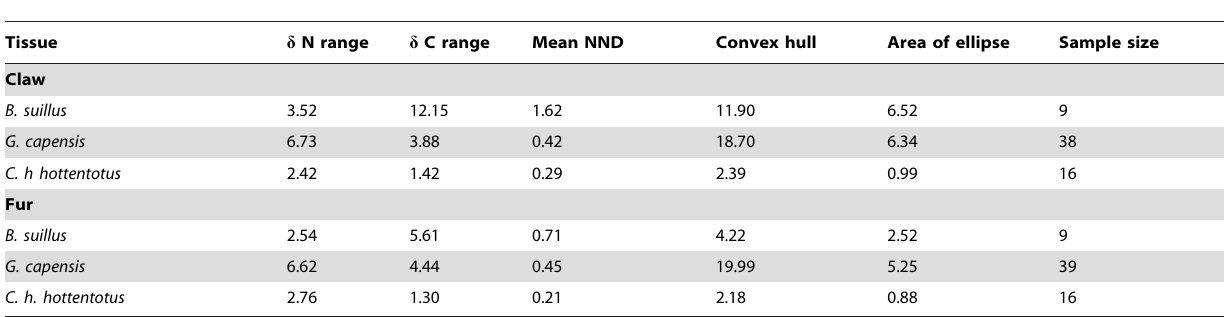
Table 3. Layman metrics and standard ellipses for claw and fur samples.